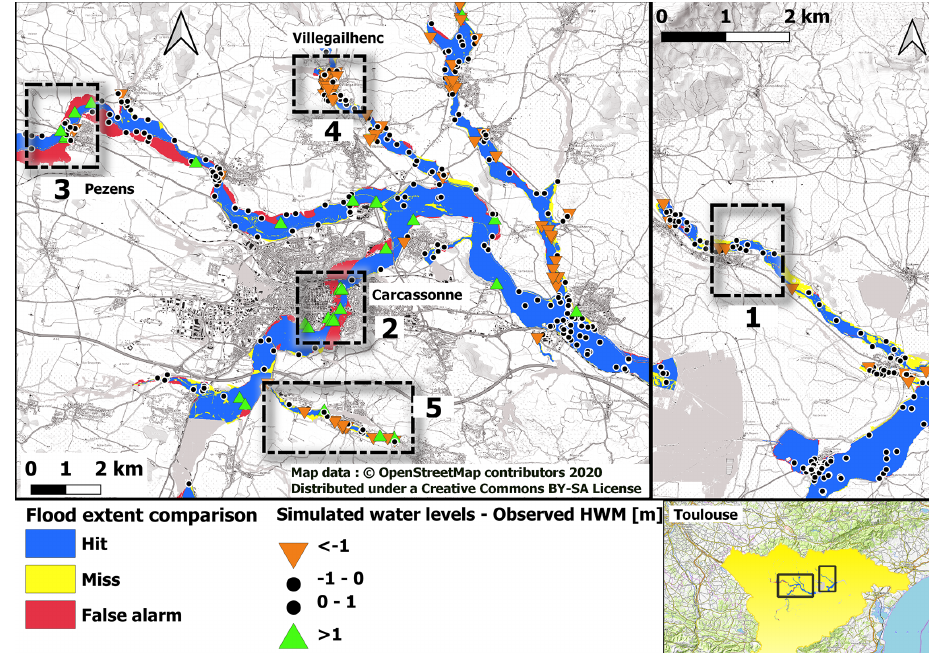
Figure 4. Simulated and observed flood areas and water levels for the Aude 2018 event and the Floodos simulation